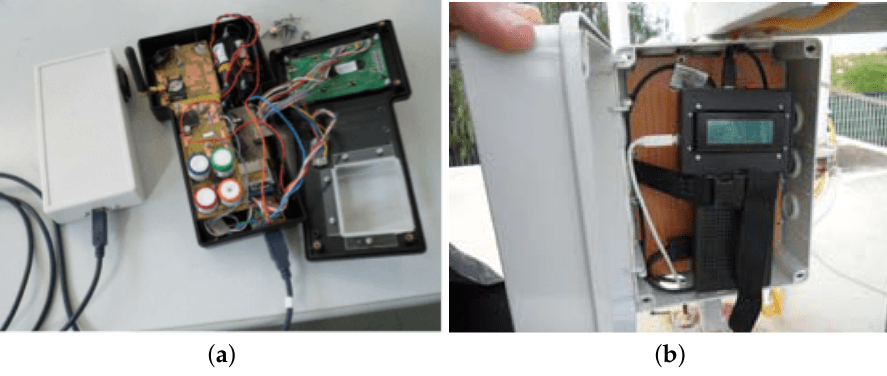
Figure 5. The NASUS IV multi-sensor system architecture, ( a ) Modules in NASUS IV; ( b ) NASUS IV as installed in the